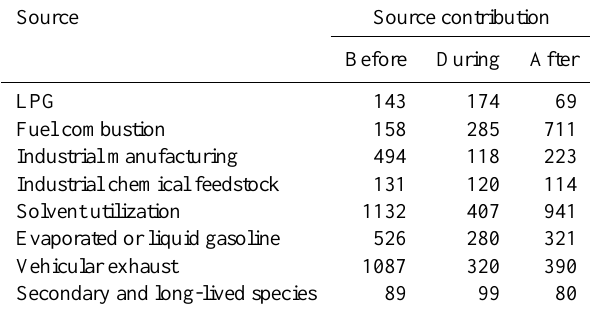
Table 5. SOAP-weighted mass contributions (µgcm − 3 ) of each VOC source before, during, and after the control period during APEC China